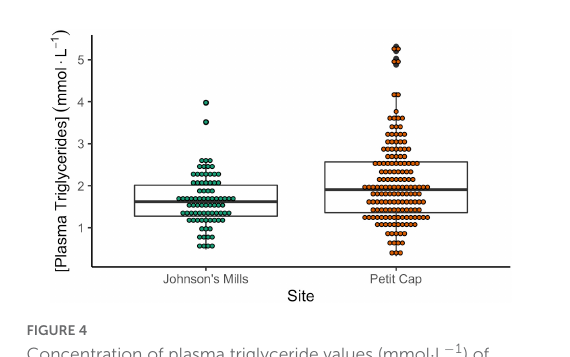
FIGURE4 Concentration of plasma triglyceride values (mmol · L − 1 ) of Semipalmated Sandpipers captured at Johnson’s Mills (Bay of Fundy) and Petit Cap (Northumberland Strait). Ages are pooled. Points show values from individual birds. Results of statistical comparisons are provided in Table 3 . Note that values used for analyses were standardized by relative fuel